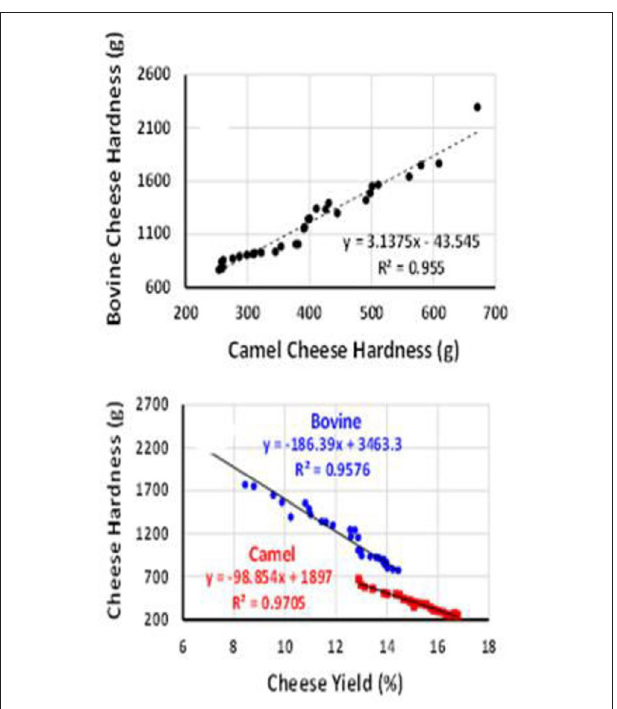
FIGURE 2 | SDS-PAGE electropherograms of the camel and bovine milk cheeses showing proteolysis in the camel milk cheeses.